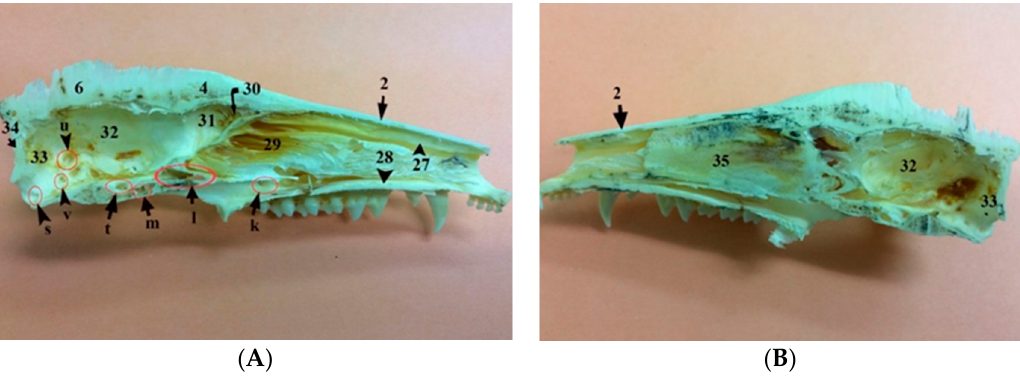
Figure 4. Photographs showing the sagittal section of the left ( A ) and right ( B ) halves of the skull of the common opossum. 2. nasal bone; 4. frontal bone; 6. parietal bone; 27. ethmoidal crest; 28. conchal crest; 29. ethmoturbinate; 30. cribriform plate of the ethmoid; 31. rostral cranial fossa; 32. middle cranial fossa; 33. caudal cranial fossa; 34. occipital bone; 35. perpendicular plate of the ethmoid; k. sphenopalatine foramen; l. orbital fissure; m. round foramen; s. hypoglossal canal; t. oval foramen; u. internal acoustic meatus; and, v. jugular foramen.